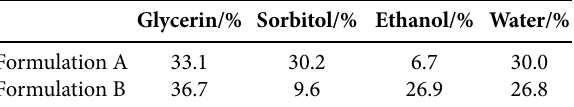
Table 2: Approximate solvent composition of two formulations for paracetamol syrup. Glycerin/% Sorbitol/% Ethanol/% Water/% Formulation